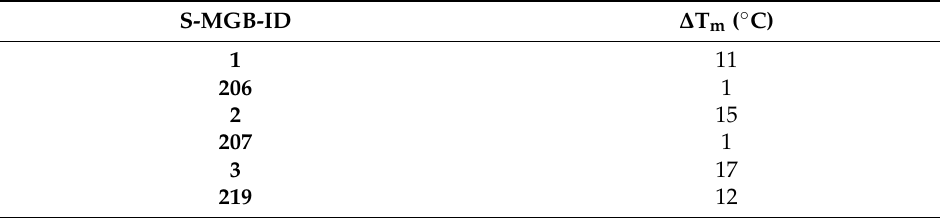
Table 2. DNA melting temperature increase against the oligomer d(5 (cid:48) -CGCATATATGCG-3 (cid:48)